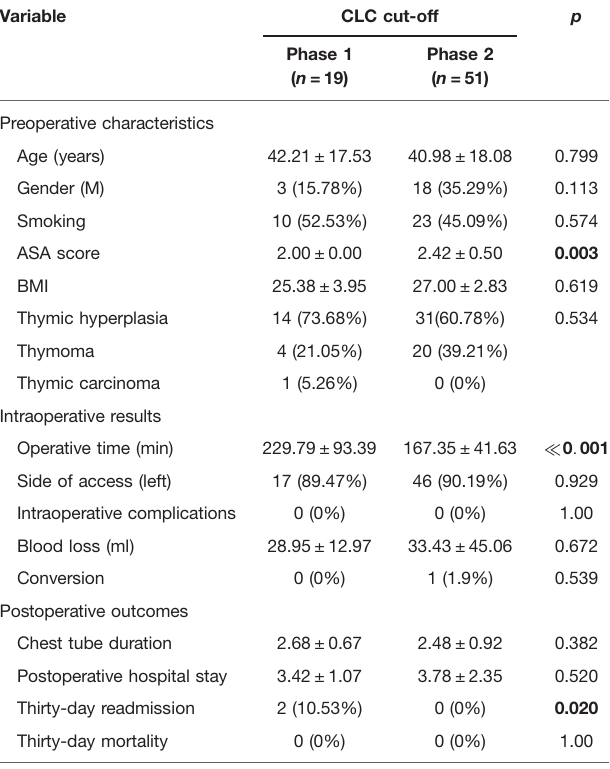
TABLE 2 | The clinicopathological characteristics and postoperative outcomes of MG patients strati fi ed by the completion of the learning curve (CLC)